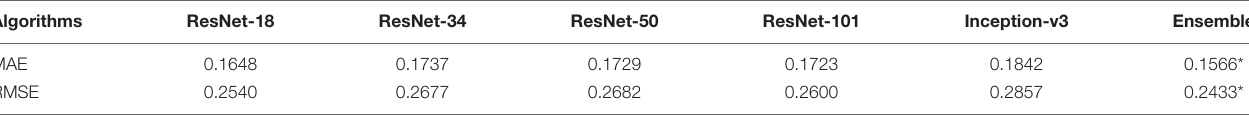
TABLE 2 | The performances of five algorithms and the ensemble learning using the validation dataset ( n = 282). Algorithms